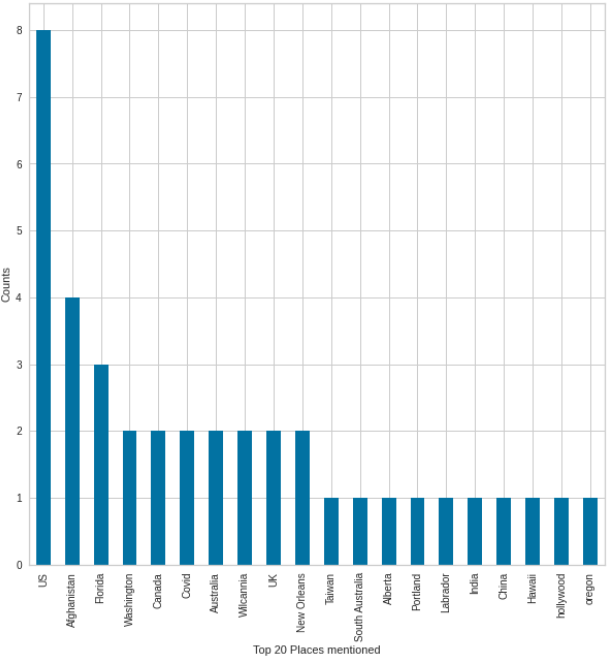
Figure 21. GPEs mentioned in positive tweets. The time period stands between 29 August 2021 and 31 August